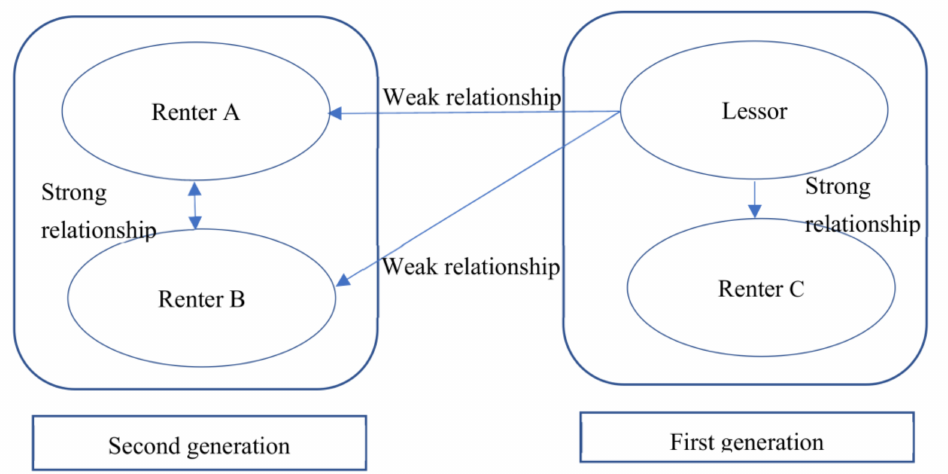
Figure 1. Intergenerational difference in social capital and land rental